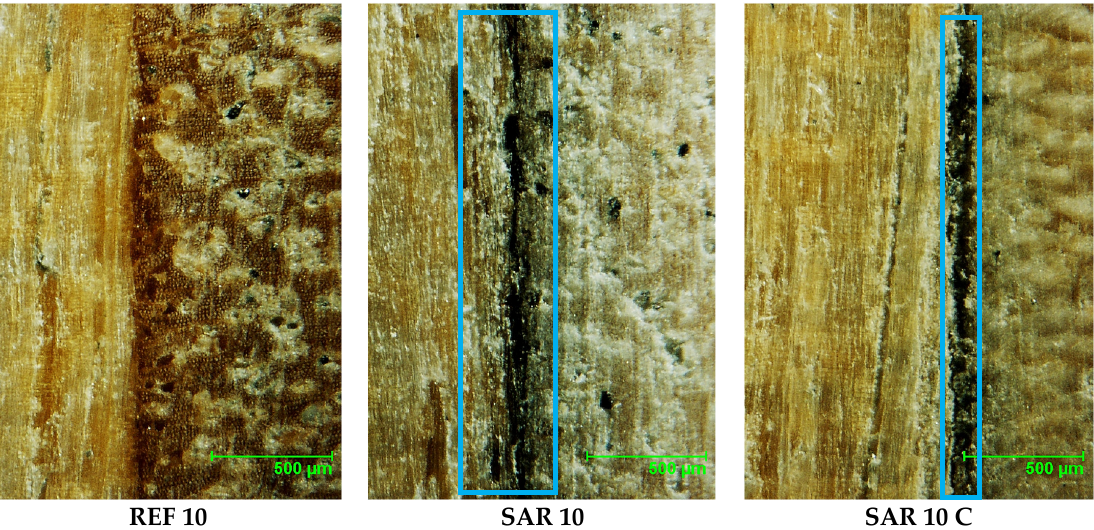
Figure 11. The images of the plywood samples bonding line of the same filler content (vertical bonding line in the middle of pictures; depth of binder penetration highlighted by blue frames).